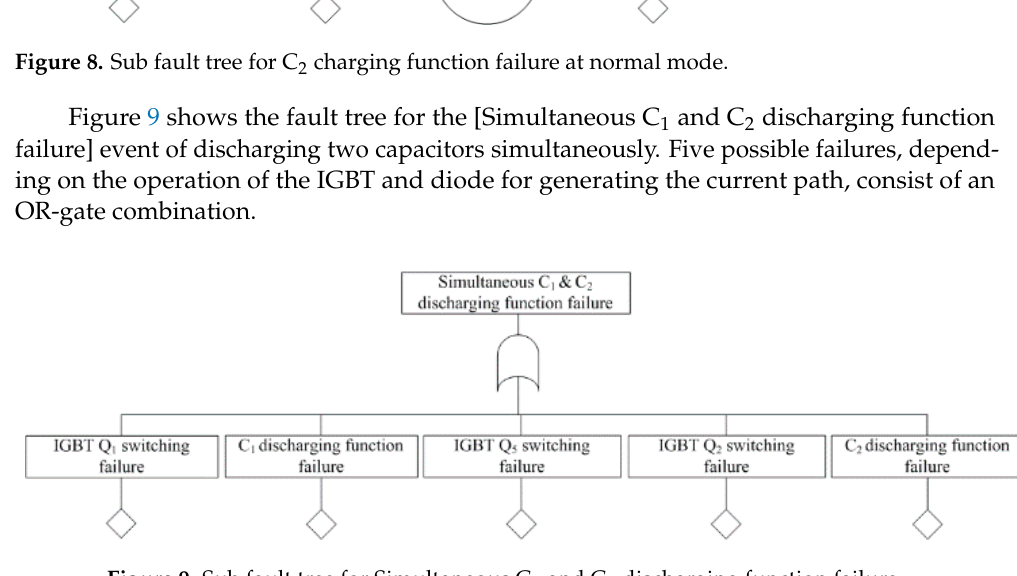
Figure 8. Sub fault tree for C 2 charging function failure at normal mode.